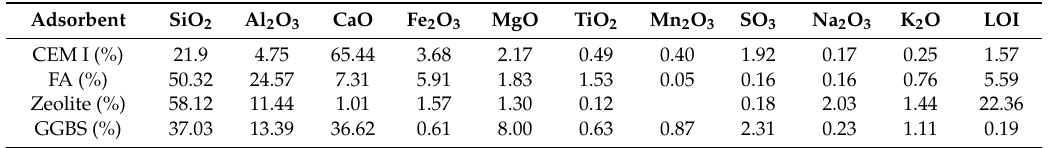
Table 1. Chemical compositions of Portland cement (CEM I), fly ash (FA), natural zeolite and ground granulated blast-furnace slag (GGBS). LOI = Loss on Ignition.